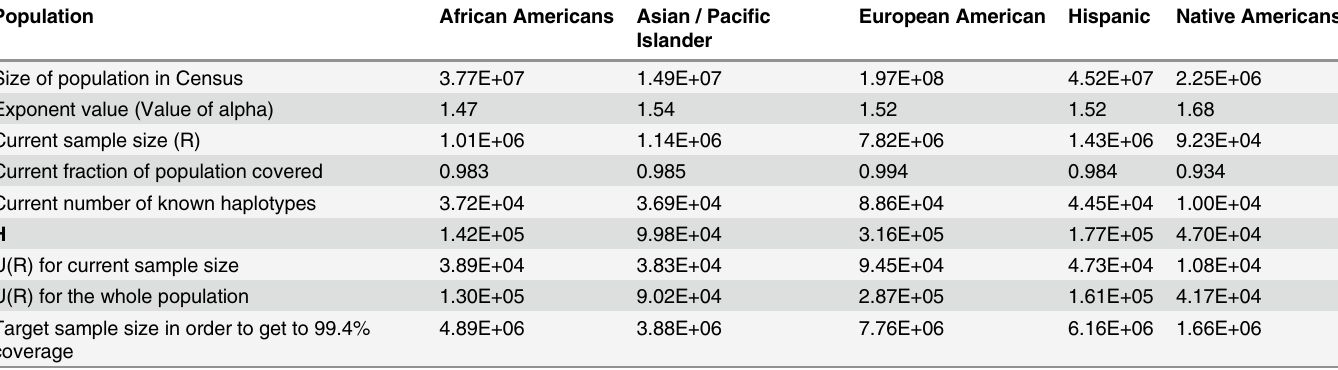
Table 2. Analysis of the five combined populations (African-Americans, Asian and Pacific Islanders, European Americans, Hispanic and Native Americans). Population